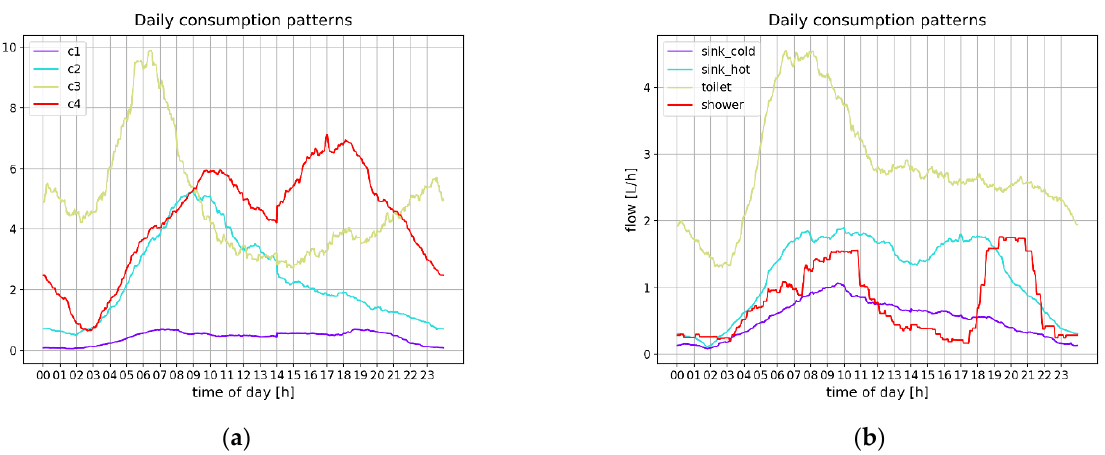
Figure 5. The daily consumption trends on the filtered data set: ( a ) the consumer outlet clusters; ( b ) the consumer outlet groups.